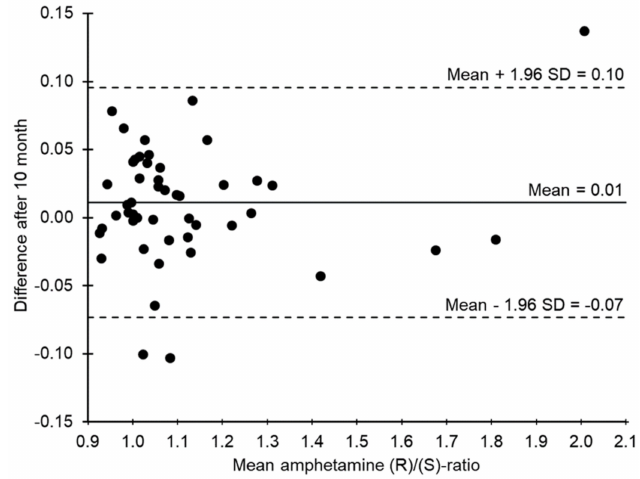
Figure 2. Bland-Altman plot of the stability of amphetamine (R)/(S) ratios after reanalysis after 10 months (n = 50). The x -axis shows the mean value of the two determinations and the y -axis shows the absolute deviation after 10